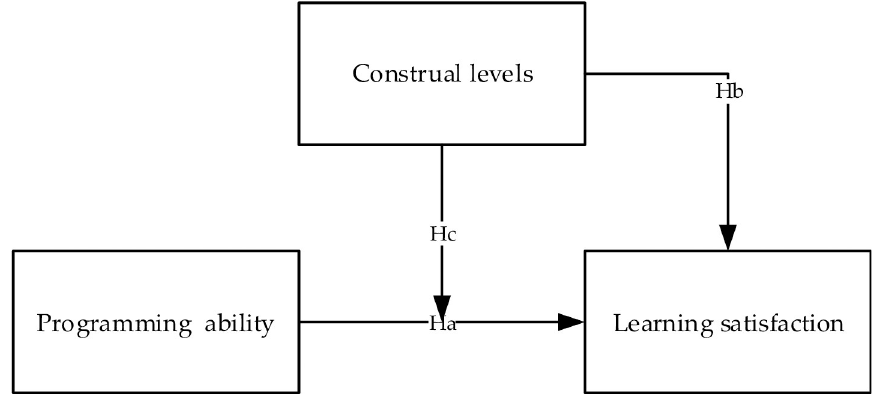
Fig 2. Research model and hypothesized